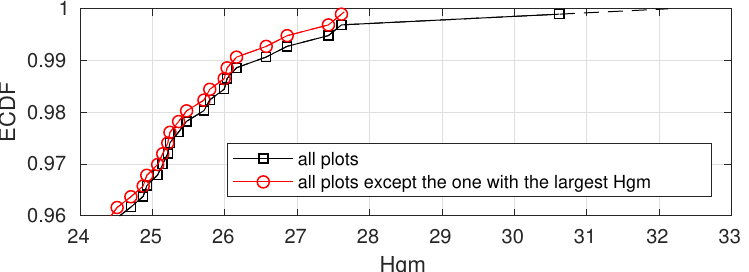
Figure 4. Largest values of attribute Hgm reference set ECDF’s in case Lieksa with and without the largest